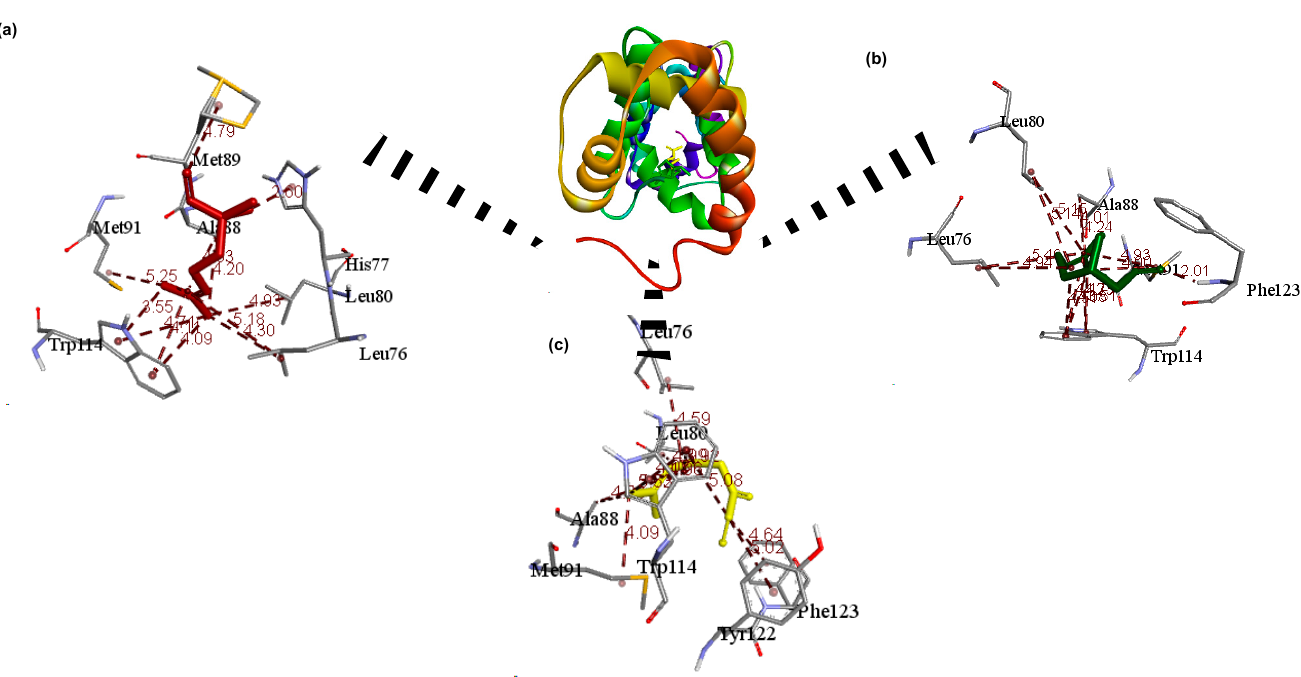
Figure 12. 3D interactions showing the selected ligands: ( a ) linalool, ( b ) citronellal, and ( c ) myrcene with the most interaction at the active sites of the OBP.